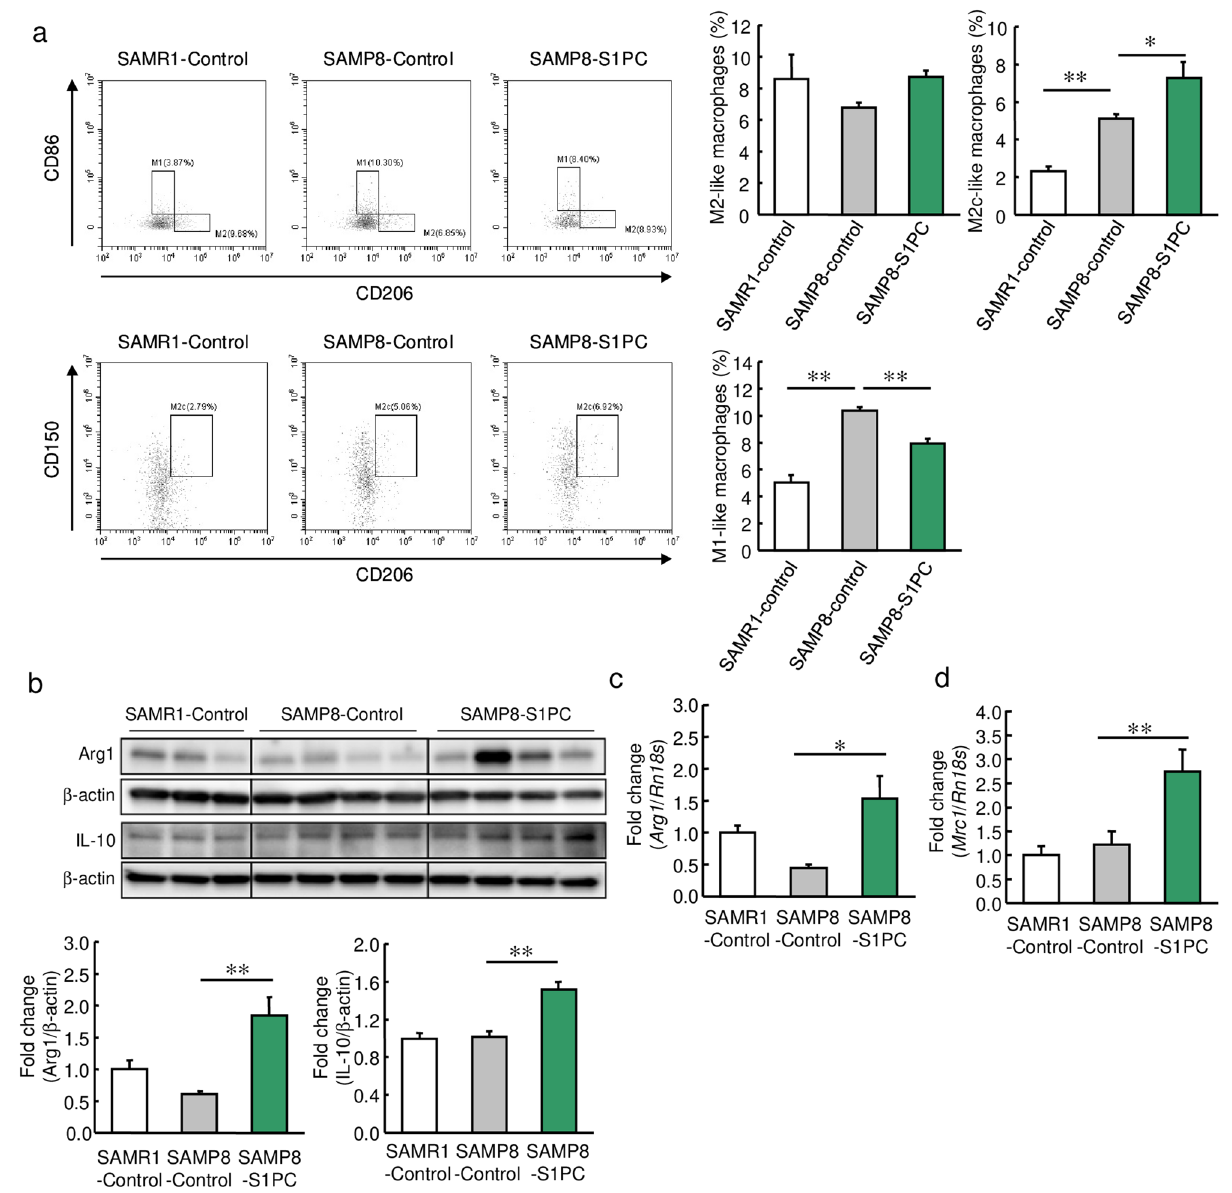
Figure 5. Effect of S1PC on macrophage polarization in SAMP8 mice. SAMR1 and SAMP8 mice were orally administered water and S1PC (5 mg/kg/day) for 6 weeks. ( a ) The populations of polarized macrophages in the splenic lymphocytes obtained from the SAMR1 and SAMP8 mice were analyzed using flow cytometry. Bar graphs show the populations of M1-like macrophages, M2-like macrophages, and M2c-like macrophages. ( b ) The relative protein levels of Arg1 and IL-10 in the splenic lymphocytes obtained from the SAMR1 and SAMP8 mice were determined using immunoblotting. The full-length blots are shown in Supplemental Fig. S16. ( c , d ) The relative mRNA levels of ( c ) Arg1 and ( d ) Mrc1 in the aortas were determined using qRT-PCR. Data are shown as mean + SEM (n = 4–8/group). Statistical differences were determined using Bonferroni’s multiple comparison test (* p < 0.05 and ** p <